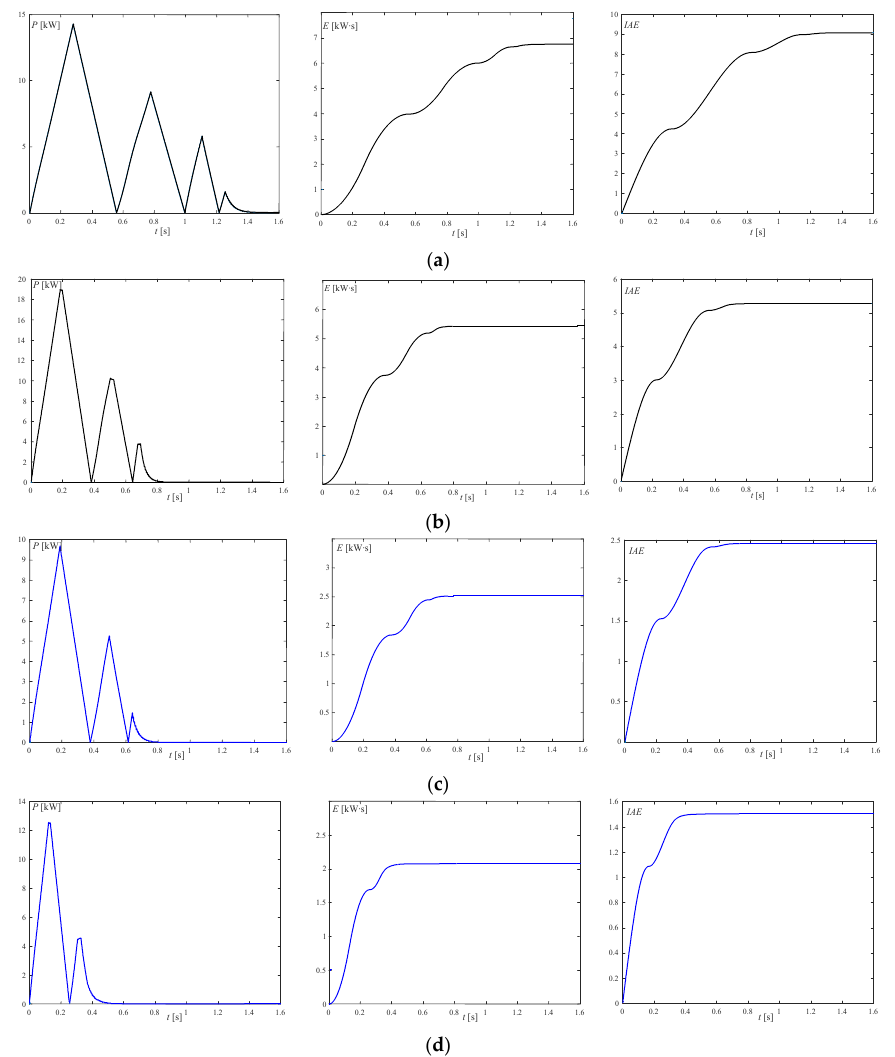
Figure 8. The power losses on a valve ( P ), energy losses ( E ), and IAE of servo drive step responses. ( a ) Assumed distance 20 mm, one stepping motor k P = 500. ( b ) Distance 20 mm, two stepping motors k P 1 = 300, k P 2 = 230. ( c ) Distance 10 mm, one stepping motor k P = 500. ( d ) One stepping motor. ( b ) Two stepping motors P-type controller with gain coefficients: k P 1 = 300, k P 2 = 230.